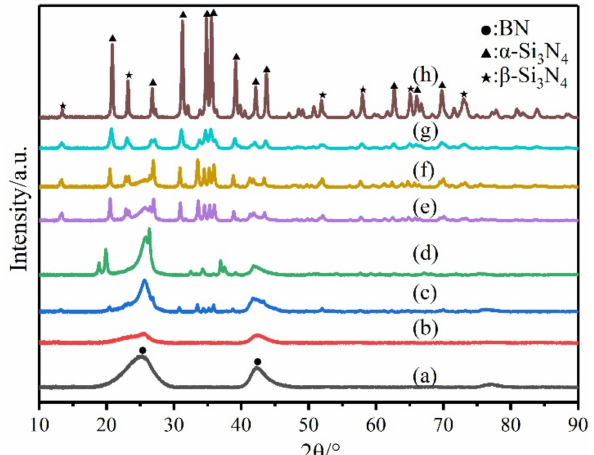
Figure 4. XRD patterns of the composite ceramics pyrolyzed at 1700 ◦ C: ( a ) P0-C; ( b ) P1-C; ( c )